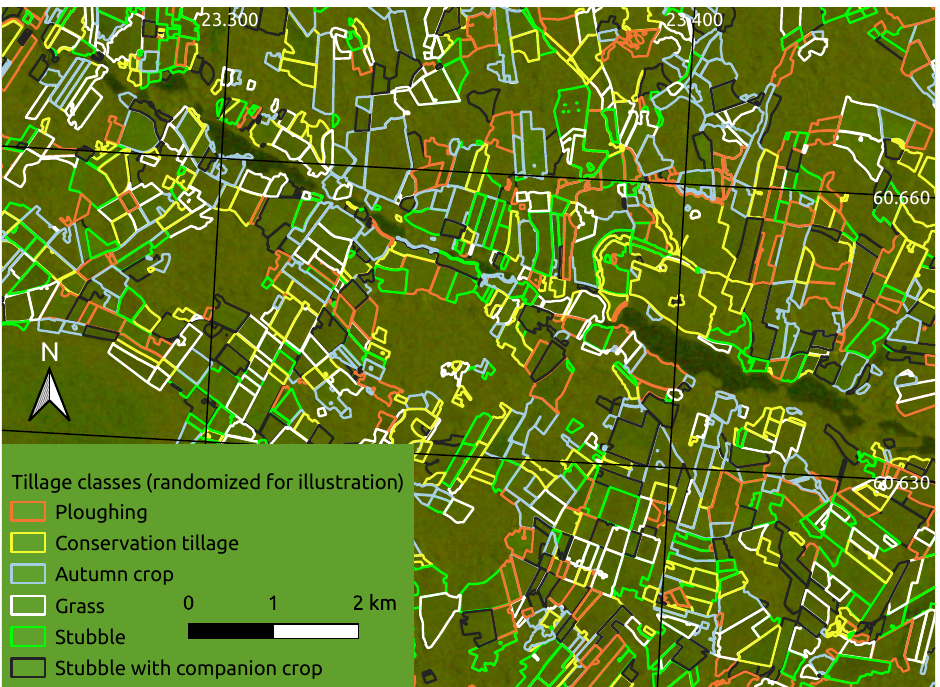
Figure 1. Foreground polygons: Autumn tillage operations annotated to six classes (colors). Background raster: Red-green rendering of a VH+VV dual polarization Sentinel-1 SAR image. Note: Due to data protection regulations, the polygons are from publicly open similar data from